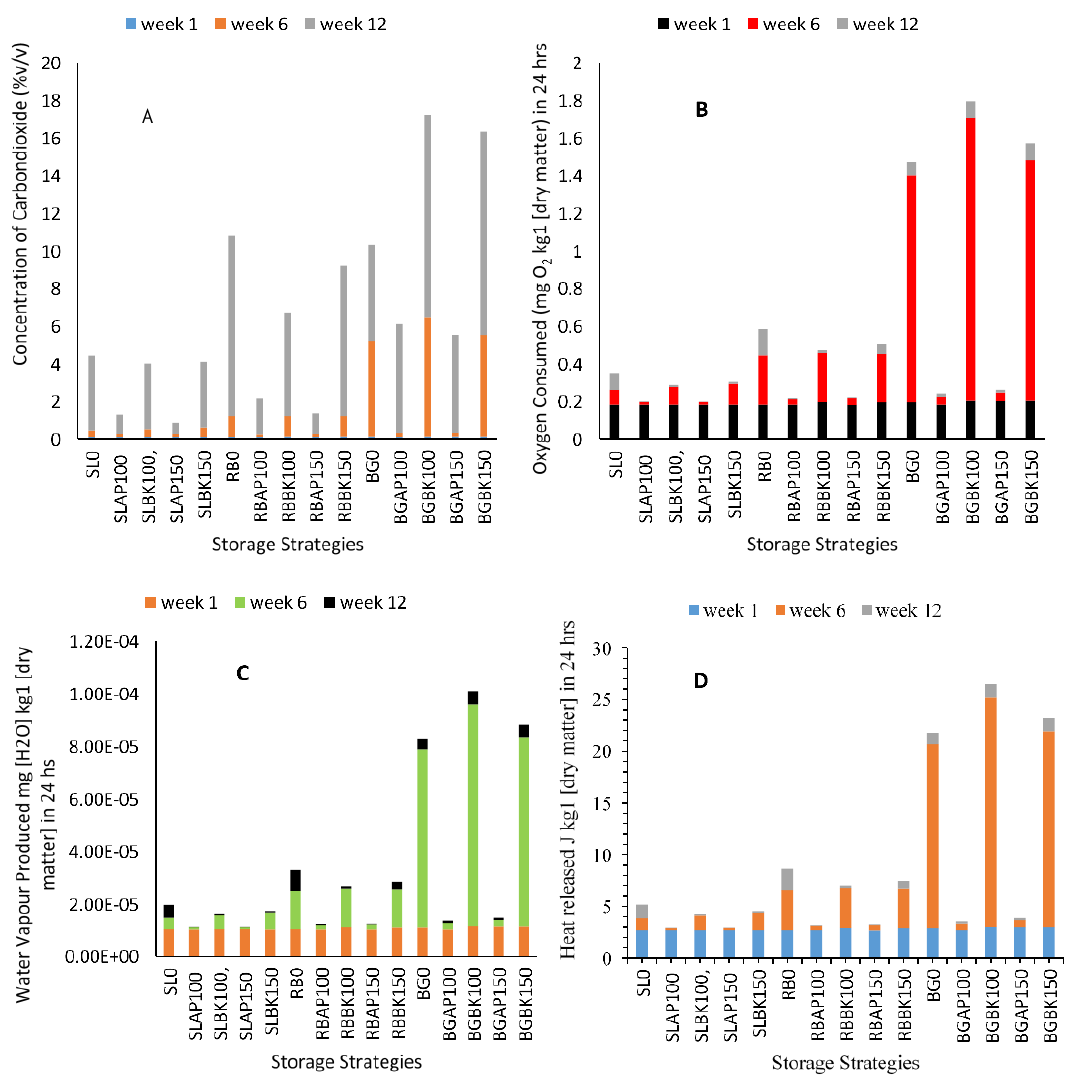
Figure 8. Gaseous exchange of breadfruit seeds for different storage strategies. ( A ) CO 2 concentration. ( B ) O 2 consumption. ( C ) Water vaper production. ( D ) Heat release.